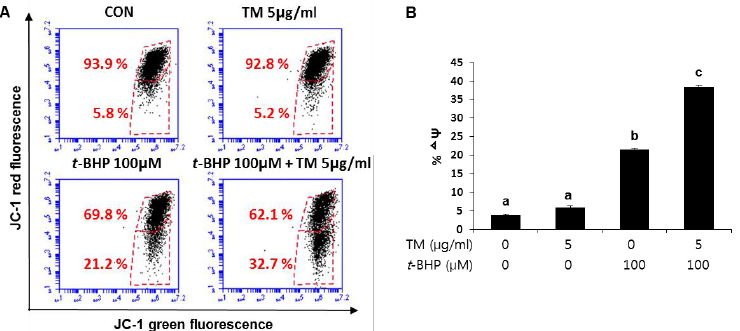
Figure 7. Enhancement of t -BHP-induced mitochondrial dysfunction by the pre-exposure of TM in HepG2 liver cells. ( A ) Cells were exposed to 5 µg of TM for 24 h before treatment with 100 µM of t -BHP for 3 h to accomplish FACS analysis of JC-1 staining. ( B ) Quantification of the mitochondrial membrane potential (∆ψ) was represented in the three independent experiments. Each value represents the mean ± SD. Values with different letters are significantly different from one another (ANOVA followed by Newman-Keuls multiple range test p < 0.05).